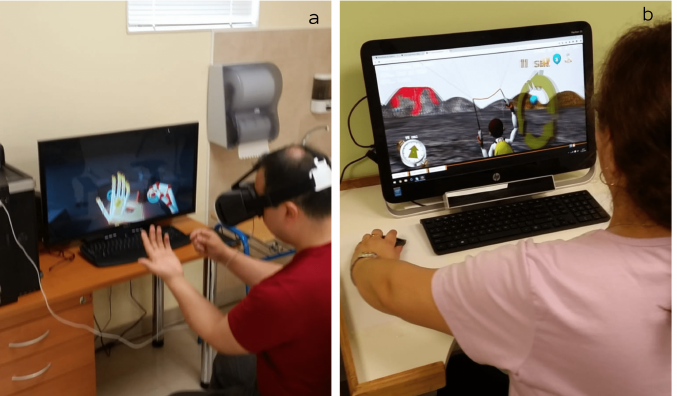
Figure 2. ( a ) Virtual Reality Therapy, and ( b ) Training with mixed Figure 2. (a) Virtual Reality Therapy, and (b) Training with mixed games.